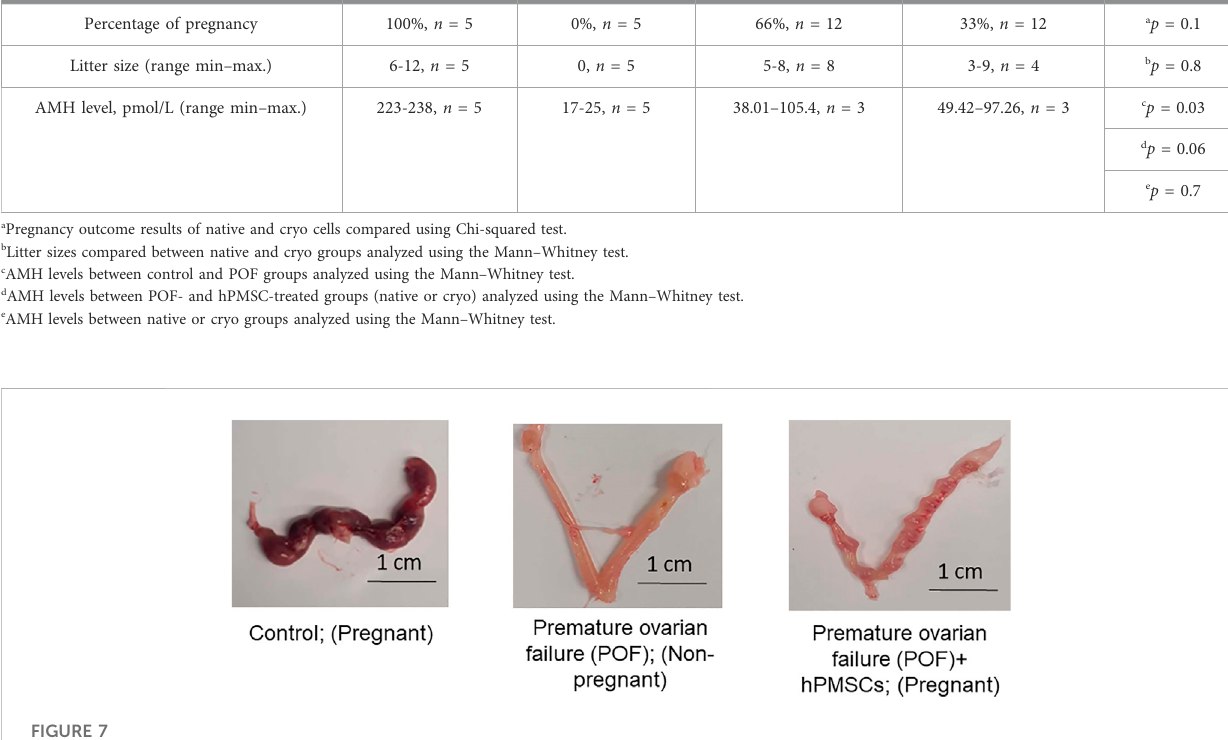
hPMSCeffectonfertilityinthePOFmousemodel.(Leftimage)Representativeimageofuterinehornsofmicefromthecontrolgroupafterbreeding withmalemicefor2 weeks.(Middleimage)RepresentativeimageofuterinehornsofmicefromthePOFgroupafterbreedingwithmalemicefor2 weeks. (Rightimage)RepresentativeimageofuterinehornsofmicefromthePOFgroupafterhPMSCintraovarian transplantation,afterbreedingwithmale mice for 2